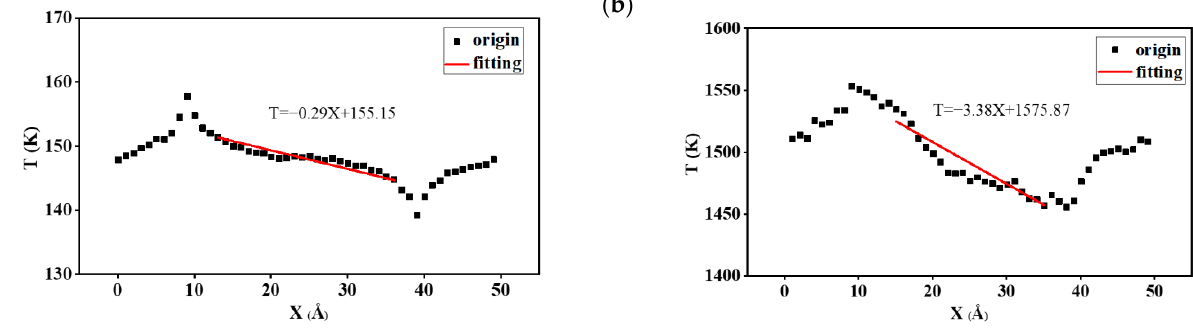
Figure 4. Temperature of the calculated model: ( a ) crystalline silicon; ( b ) porous silicon structure.